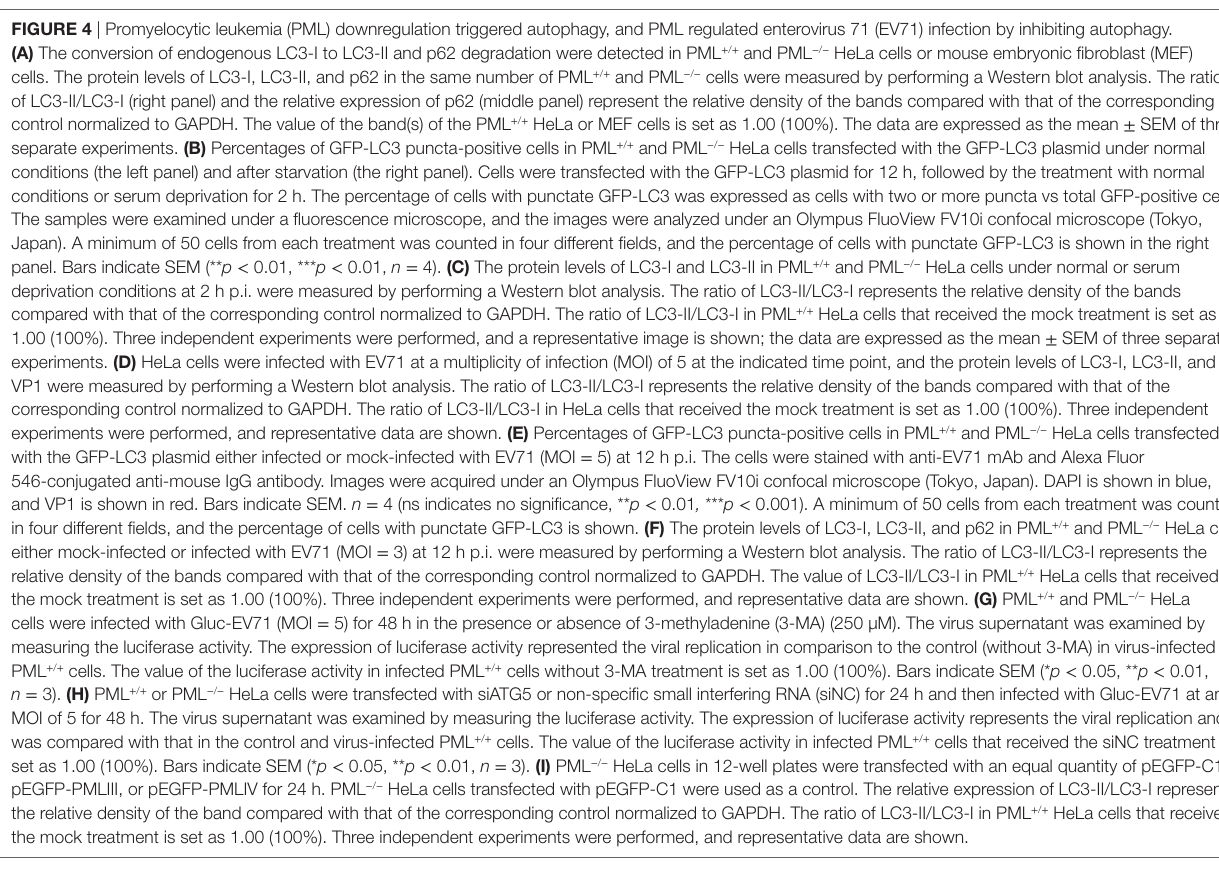
FigUre 4 | Promyelocytic leukemia (PML) downregulation triggered autophagy, and PML regulated enterovirus 71 (EV71) infection by inhibiting autophagy. (a) The conversion of endogenous LC3-I to LC3-II and p62 degradation were detected in PML + / + and PML − / − HeLa cells or mouse embryonic fibroblast (MEF) cells. The protein levels of LC3-I, LC3-II, and p62 in the same number of PML + / + and PML − / − cells were measured by performing a Western blot analysis. The ratio of LC3-II/LC3-I (right panel) and the relative expression of p62 (middle panel) represent the relative density of the bands compared with that of the corresponding control normalized to GAPDH. The value of the band(s) of the PML + / + HeLa or MEF cells is set as 1.00 (100%). The data are expressed as the mean ± SEM of three separate experiments. (B) Percentages of GFP-LC3 puncta-positive cells in PML + / + and PML − / − HeLa cells transfected with the GFP-LC3 plasmid under normal conditions (the left panel) and after starvation (the right panel). Cells were transfected with the GFP-LC3 plasmid for 12 h, followed by the treatment with normal conditions or serum deprivation for 2 h. The percentage of cells with punctate GFP-LC3 was expressed as cells with two or more puncta vs total GFP-positive cells. The samples were examined under a fluorescence microscope, and the images were analyzed under an Olympus FluoView FV10i confocal microscope (Tokyo, Japan). A minimum of 50 cells from each treatment was counted in four different fields, and the percentage of cells with punctate GFP-LC3 is shown in the right panel. Bars indicate SEM (** p < 0.01, *** p < 0.01, n = 4). (c) The protein levels of LC3-I and LC3-II in PML + / + and PML − / − HeLa cells under normal or serum deprivation conditions at 2 h p.i. were measured by performing a Western blot analysis. The ratio of LC3-II/LC3-I represents the relative density of the bands compared with that of the corresponding control normalized to GAPDH. The ratio of LC3-II/LC3-I in PML + / + HeLa cells that received the mock treatment is set as 1.00 (100%). Three independent experiments were performed, and a representative image is shown; the data are expressed as the mean ± SEM of three separate experiments. (D) HeLa cells were infected with EV71 at a multiplicity of infection (MOI) of 5 at the indicated time point, and the protein levels of LC3-I, LC3-II, and VP1 were measured by performing a Western blot analysis. The ratio of LC3-II/LC3-I represents the relative density of the bands compared with that of the corresponding control normalized to GAPDH. The ratio of LC3-II/LC3-I in HeLa cells that received the mock treatment is set as 1.00 (100%). Three independent experiments were performed, and representative data are shown. (e) Percentages of GFP-LC3 puncta-positive cells in PML + / + and PML − / − HeLa cells transfected with the GFP-LC3 plasmid either infected or mock-infected with EV71 (MOI = 5) at 12 h p.i. The cells were stained with anti-EV71 mAb and Alexa Fluor 546-conjugated anti-mouse IgG antibody. Images were acquired under an Olympus FluoView FV10i confocal microscope (Tokyo, Japan). DAPI is shown in blue, and VP1 is shown in red. Bars indicate SEM. n = 4 (ns indicates no significance, ** p < 0.01 , *** p < 0.001). A minimum of 50 cells from each treatment was counted in four different fields, and the percentage of cells with punctate GFP-LC3 is shown. (F) The protein levels of LC3-I, LC3-II, and p62 in PML + / + and PML − / − HeLa cells either mock-infected or infected with EV71 (MOI = 3) at 12 h p.i. were measured by performing a Western blot analysis. The ratio of LC3-II/LC3-I represents the relative density of the bands compared with that of the corresponding control normalized to GAPDH. The value of LC3-II/LC3-I in PML + / + HeLa cells that received the mock treatment is set as 1.00 (100%). Three independent experiments were performed, and representative data are shown. (g) PML + / + and PML − / − HeLa cells were infected with Gluc-EV71 (MOI = 5) for 48 h in the presence or absence of 3-methyladenine (3-MA) (250 µM). The virus supernatant was examined by measuring the luciferase activity. The expression of luciferase activity represented the viral replication in comparison to the control (without 3-MA) in virus-infected PML + / + cells. The value of the luciferase activity in infected PML + / + cells without 3-MA treatment is set as 1.00 (100%). Bars indicate SEM (* p < 0.05, ** p <